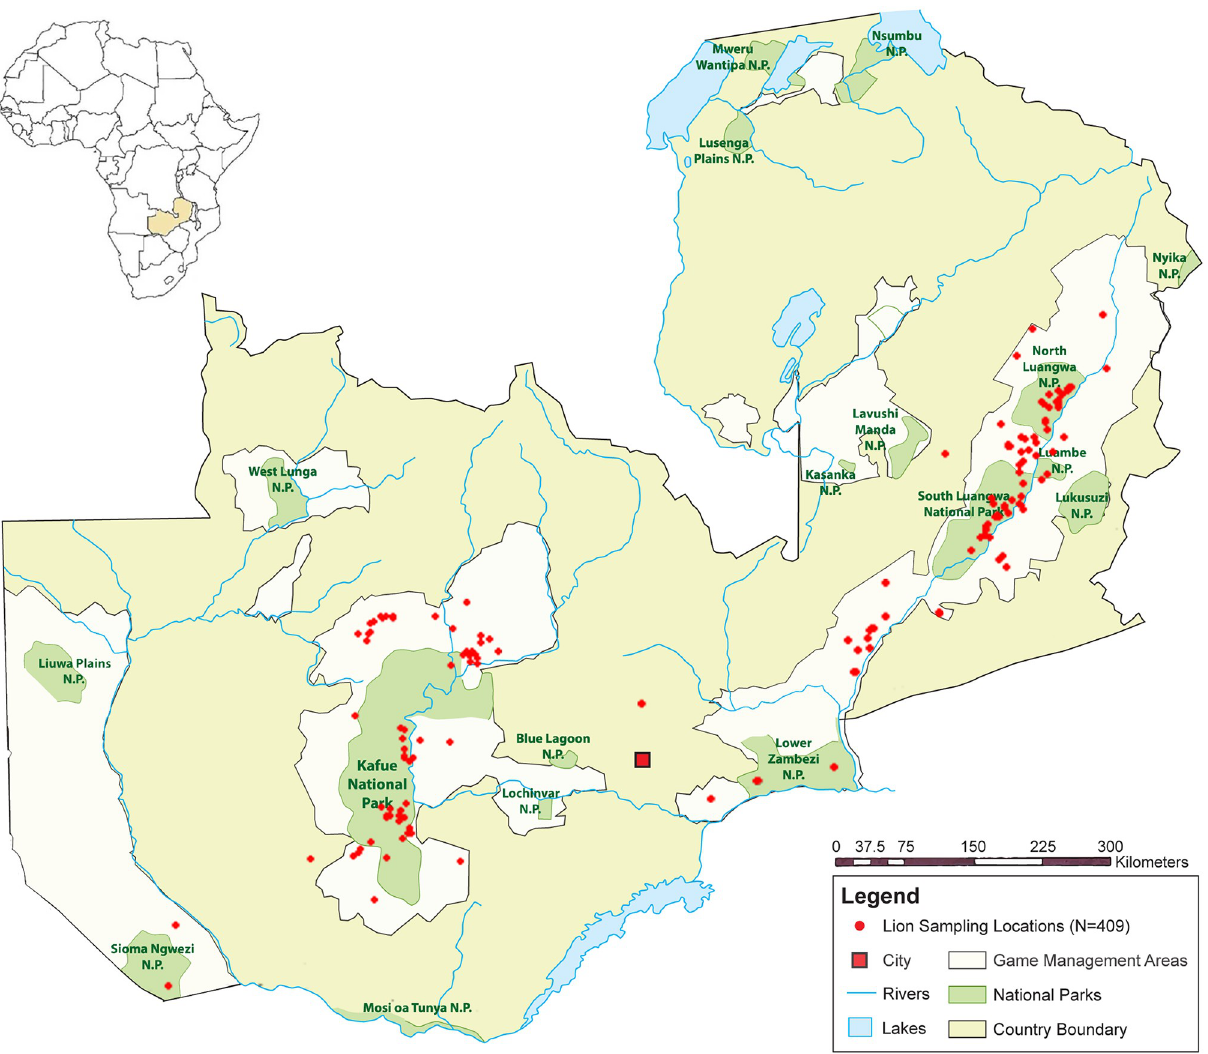
Fig 1. Map of Zambia with sampling locations. Sample locations are latitude and longitude coordinates of GPS location at sampling (181 lions at 181 locations) or a central location based on sampling area (228 lions at 33 locations). Detailed location information is in S1